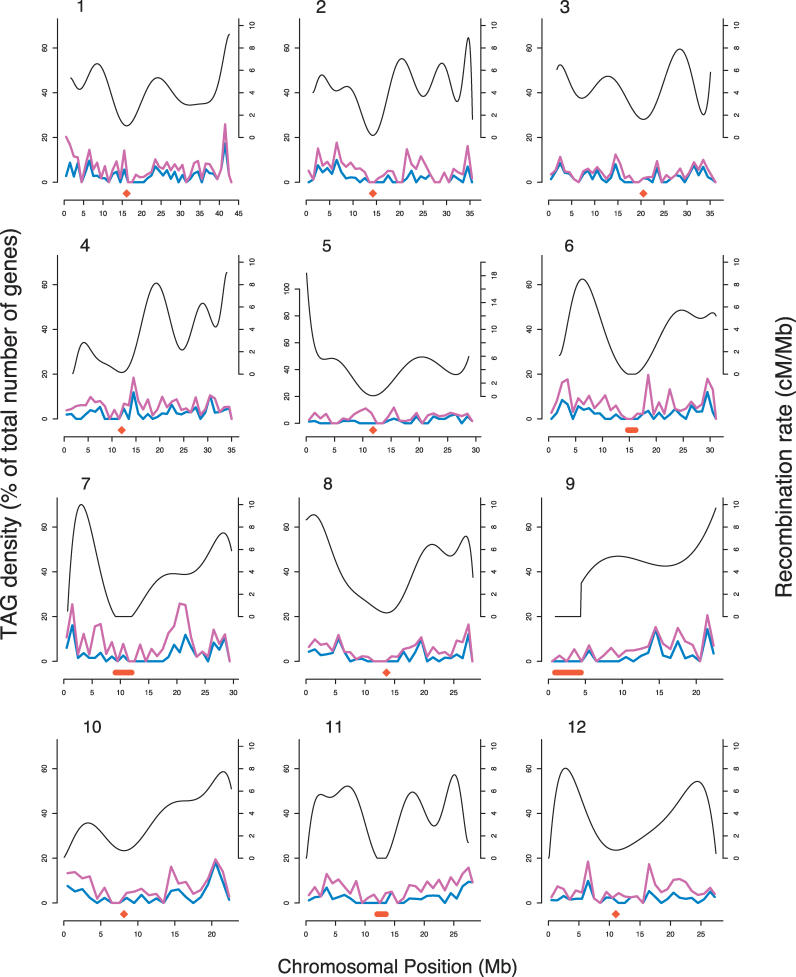
Recombination Rate Estimates and Density of TAGs (Number of TAGs/Total Number of Genes) along O. sativa ChromosomeRecombination estimates are represented by the black lines. Density estimates are based on the H/0 dataset (blue lines) and H/10 dataset (pink lines).Centromere positions are marked in orange.